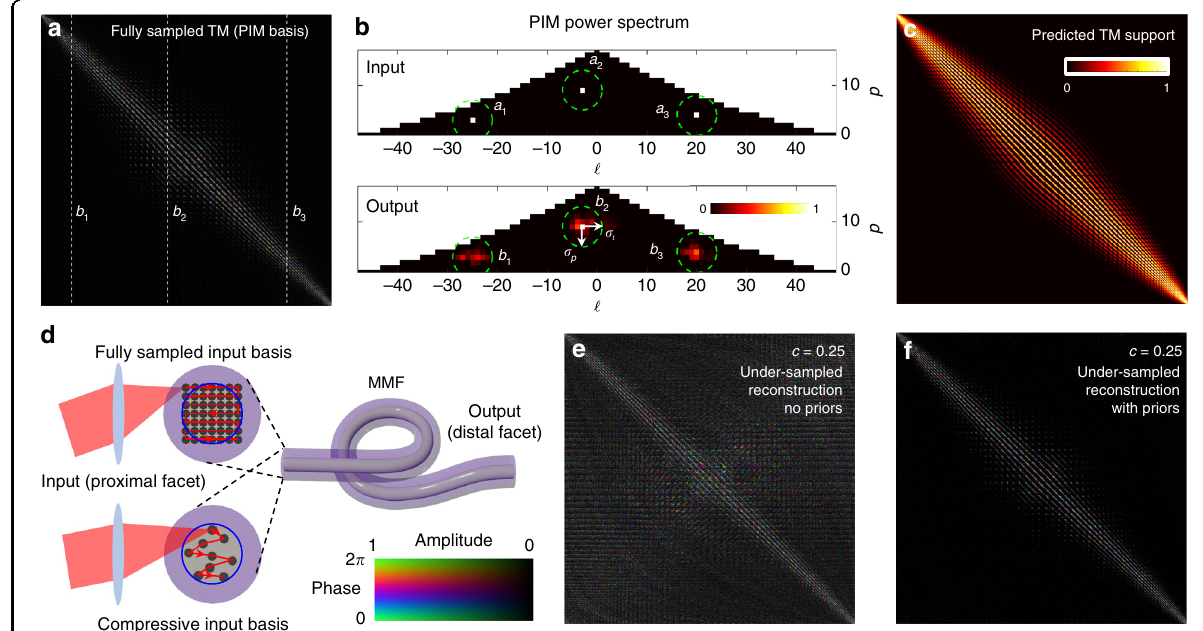
Fig. 1 Compressive sampling of the TM of an MMF. a A fully sampled TM of an ~30 cm segment of step-index MMF supporting 754 modes at a wavelength of 633 nm (NA = 0.22, core diameter = 50 μ m). Here, represented in the PIM basis, the TM shows strong diagonal features and a well- de fi ned off-diagonal structure. b PIMs are indexed by an azimuthal index ‘ , describing the orbital angular momentum carried by a PIM, and a radial index p , which is related to the degree of radial momentum carried by the PIM. The heat maps in ( b ) show the power spectra of three input fi bre modes (a 1 , a 2 , and a 3 ) and the three corresponding output fi elds (b 1 , b 2 , and b 3 ) represented in the ( ‘ , p )-space of the PIM basis, which also correspond to the three columns marked in ( a ). The colour of pixel ( ‘ , p ) corresponds to the relative power found in the mode with indices ( ‘ , p ). We see that each input couples only to modes with similar ‘ and p indices during propagation through the fi bre (see also Movie 1 and SI Fig. S7). c A support for the TM can be predicted by estimating the degrees of modal coupling σ ‘ and σ p , indicating areas that are likely to contain little to no power (see the Methods for details); here, σ ‘ = 4 and σ p = 2. d Schematic showing the input modes (a focussed point swept across the input facet) used to fully sample (top) or under-sample (bottom) the TM of the MMF. In the over-sampled case, the input focussed beam is scanned across an overlapping Cartesian grid of points. In the under-sampled case, points are addressed in a hyper-uniform pattern. e An under-sampled TM ( c = 0.25) reconstructed using the columnwise method with no priors and then transformed into the PIM basis. In this case, the TM is evidently reconstructed with low fi delity: it exhibits considerable off-diagonal power, and its normalised correlation with the fully sampled TM is 0.23. This correlation is calculated as the squared modulus of the normalised overlap integral between the complex-valued reconstructed TM and the fully sampled TM. f TM reconstructed using the same data as in ( e ) but using FISTA with a predicted support. In this case, the TM is reconstructed with higher fi delity, and the normalised correlation with the fully sampled TM rises to 0.88. Note: ( a ) and ( f ) are reproduced on a larger scale in Supplementary Information (SI) Figs. S3,